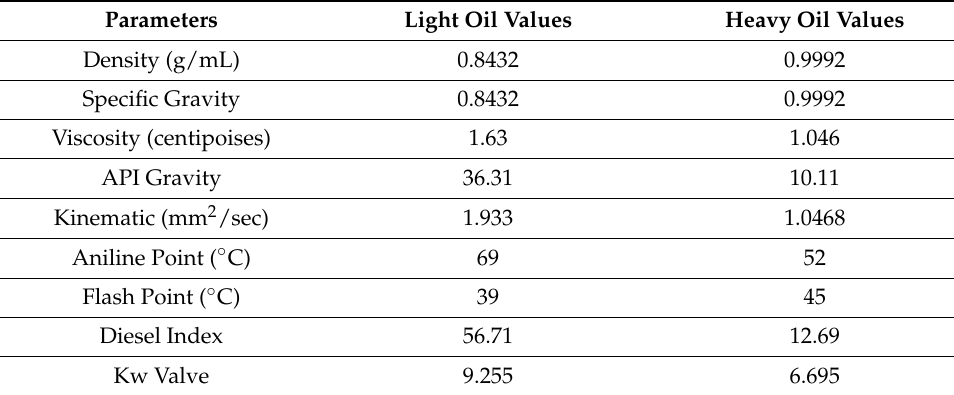
Table 4. Physical properties of Liquid oil after Cracking of Tube Rubber.